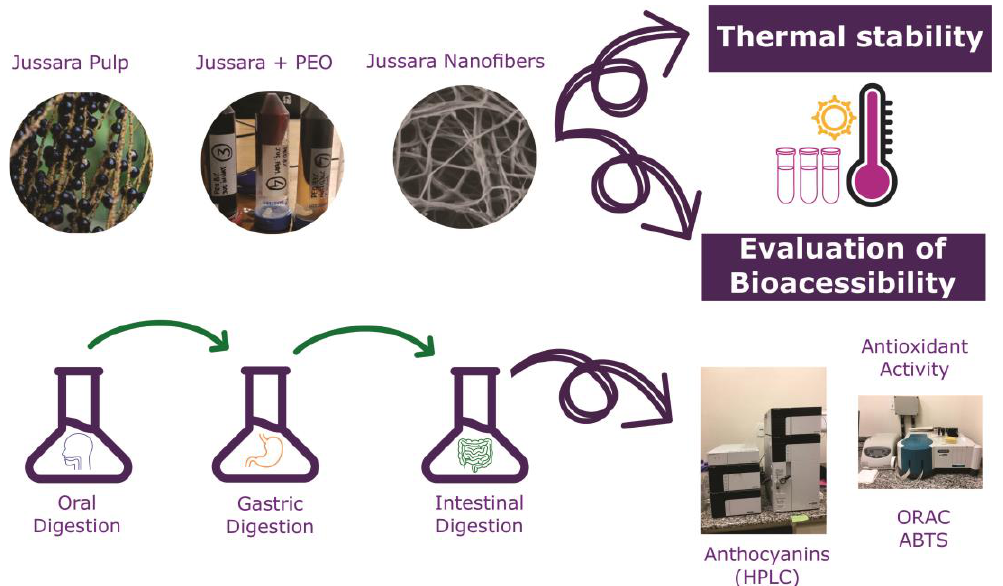
Figure 3. Schematical summary of the acquired